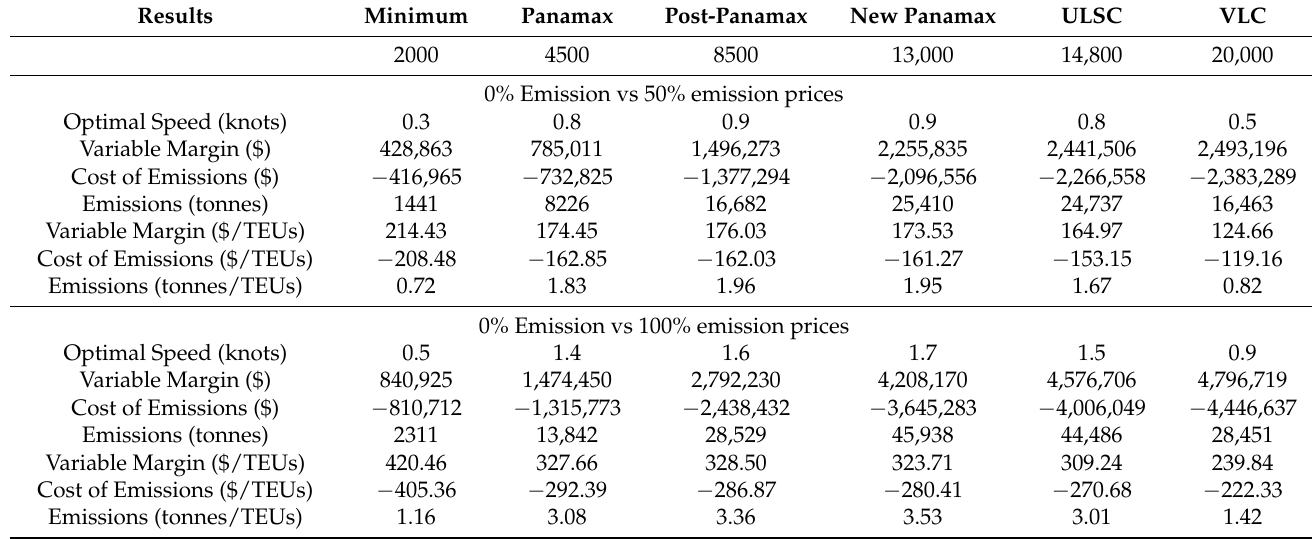
Table 8. Differences in optimal behaviour of selected